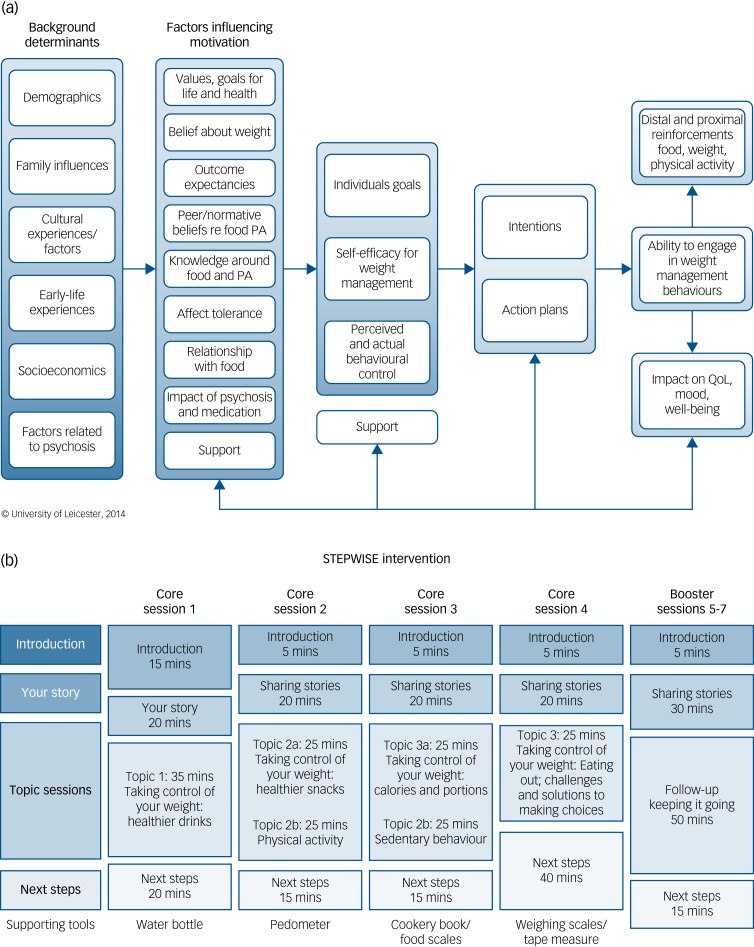
The STEPWISE intervention.(a) Theoretical framework. The STEPWISE intervention was codesigned by a team with expertise in the development of obesity and lifestyle intervention programmes, mental healthcare professionals and researchers, and service users and refined during a four-cycle pilot. It was underpinned by self-regulation and self-efficacy theories and the relapse prevention model. (b). Curriculum. The STEPWISE intervention comprised four 2.5 h foundation group education sessions, designed to be delivered to small groups of 6–8 participants over 4 consecutive weeks followed by three 2.5 h follow-up ‘booster’ sessions at 3-monthly intervals and fortnightly support, usually by telephone. The content was determined by the specific difficulties described by people with schizophrenia. The sessions incorporated adequate breaks. The educational style was non-judgemental and facilitative to allow the participants to discuss their beliefs about weight and explore own solutions. Strategies was employed to maintain engagement including telephone call reminders, provision of taxis to the venue, afternoon sessions with lunch provided and use of incentives described as supporting tools. PA, physical activity; QoL, quality of life.